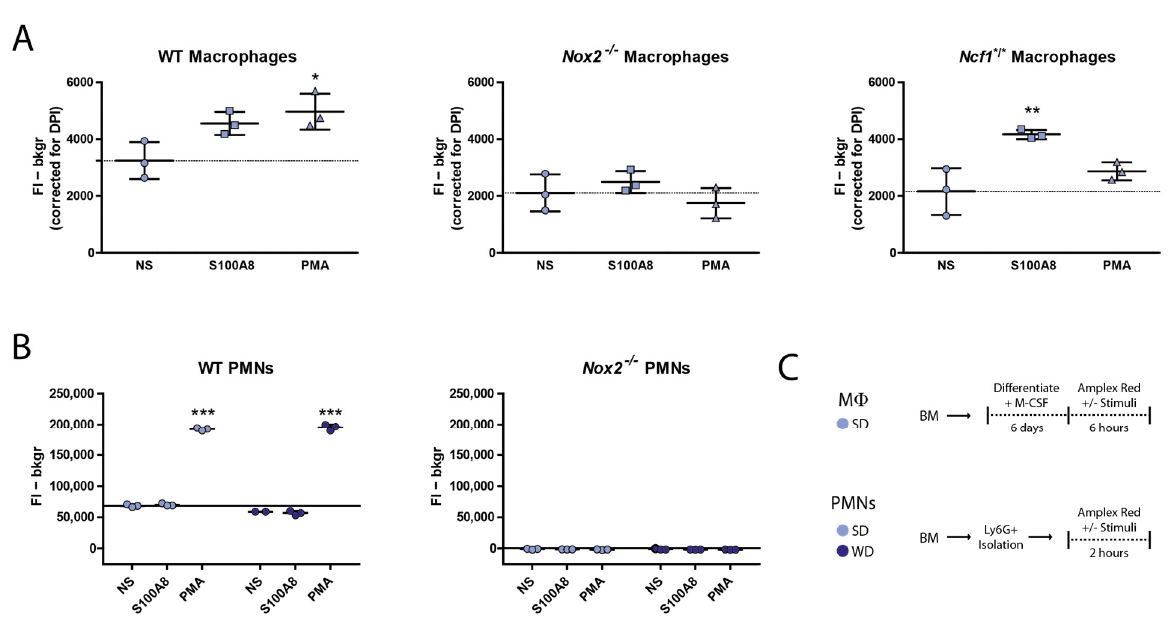
Figure 3. Nox2 − / − macrophages produce basal levels of ROS but fail to upregulate these upon stimulation with PMA and S100A8. ( A ) Amplex Red assay readout (@545-15nm) of WT, Nox2 − / − and Ncf1* / * macrophages differentiated for six days in presence of M-CSF (15 ng/mL) ( C ), and of WT an Nox2 − / − PMNs ( B ) isolated from fresh bone marrow using positive selection of Ly6G + cells ( C ). Data are presented as mean and SD. *, p < 0.05; **, p < 0.01; ***, p < 0.001 compared to non-stimulated (NS).